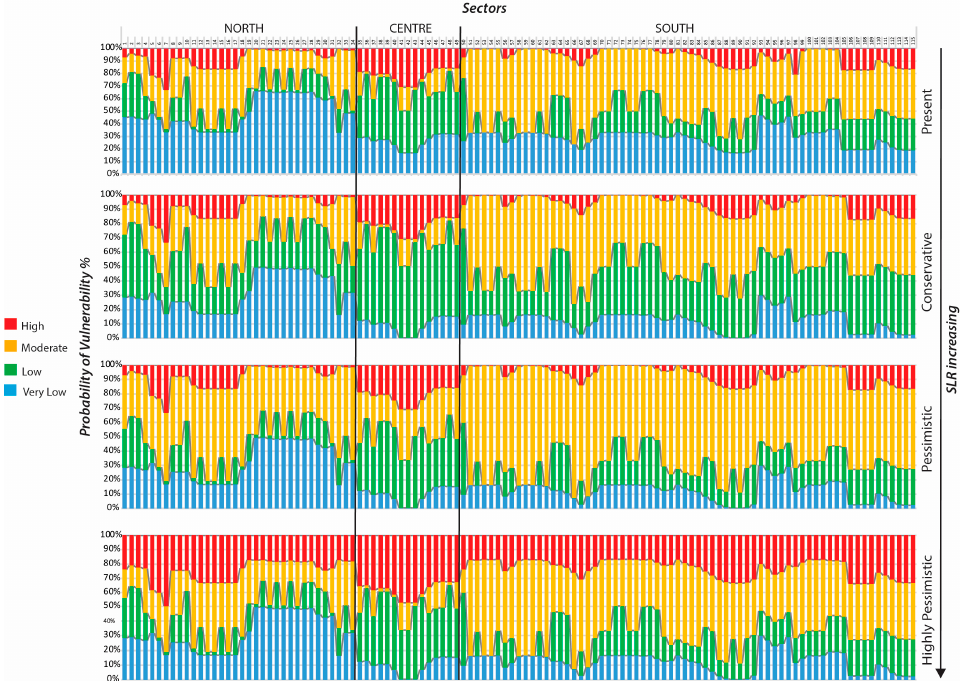
Figure 8. Vulnerability behaviors along the stretches of coast considering present and future IPCC SLR scenarios the 115 cells spatial unit (n = 115).